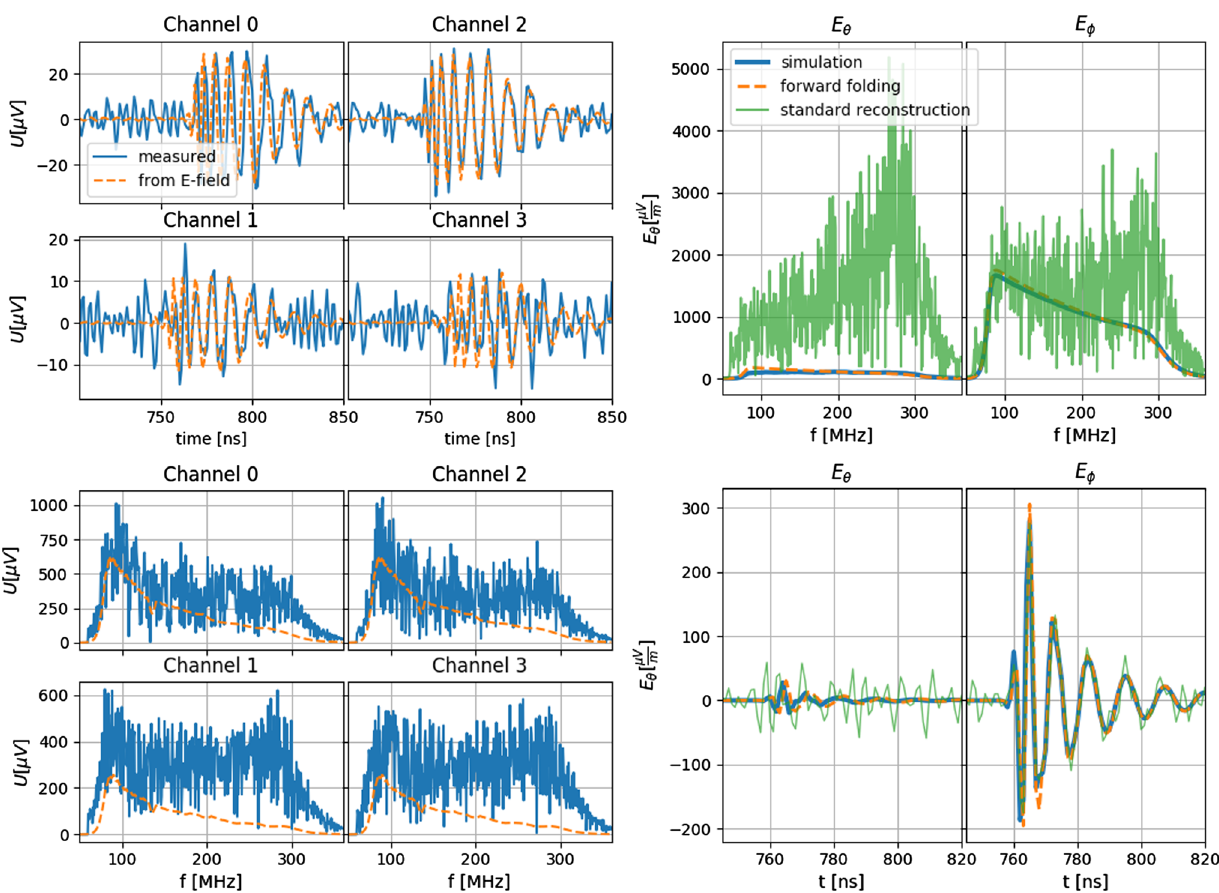
Fig. 7 Example of the electric-field reconstruction using the standard and the forward folding technique. Left panels: Voltage traces of four spatially displaces antennas. Shown are both the time- (top) and fre- quency domain (bottom). The solid blue curve represents the measured voltages whereas the dashed orange curve shows the analytic solution of the forward folding technique. Channels 0, 2 and 1, 3 are parallel, the